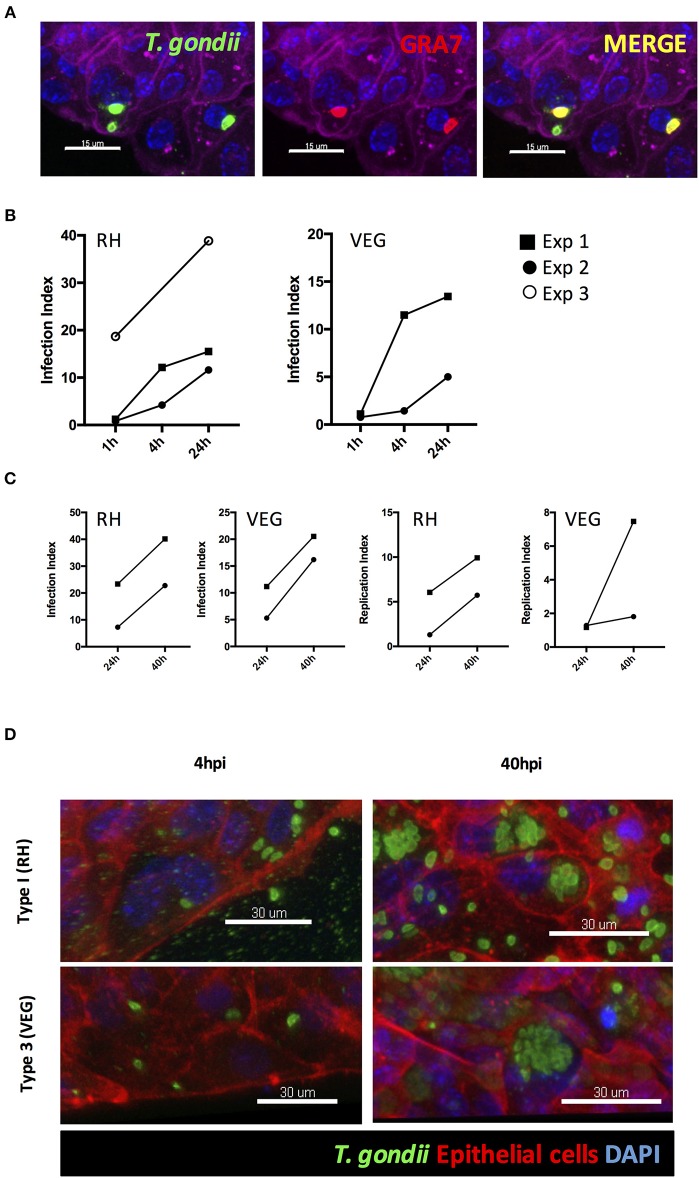
T. gondii successfully invades, and replicates within, collagen-supported epithelial sheets. Collagen-supported epithelial sheets (C57Bl/6) were infected for the indicated times with 1 × 106
T. gondii RH or VEG. (A) Confocal images showing T. gondii (SAG1; green) in PV (GRA7; red) following invasion of epithelial cells (Phalloidin; purple) (scale bars = 15 μm). (B,C) Quantification of the percentage of epithelial cells containing parasites (Infection Index) and the proportion of cells containing replicating parasites (Replication Index) at the indicated time-points post infection. Pooled data from 2 to 3 independent experiments are shown (each data point indicates the mean of an individual experiment) (D) Representative z-stack confocal images showing T. gondii invasion of the intestinal epithelium at 4 hpi, and replication of T. gondii at 40 hpi (scale bars = 30 μm).